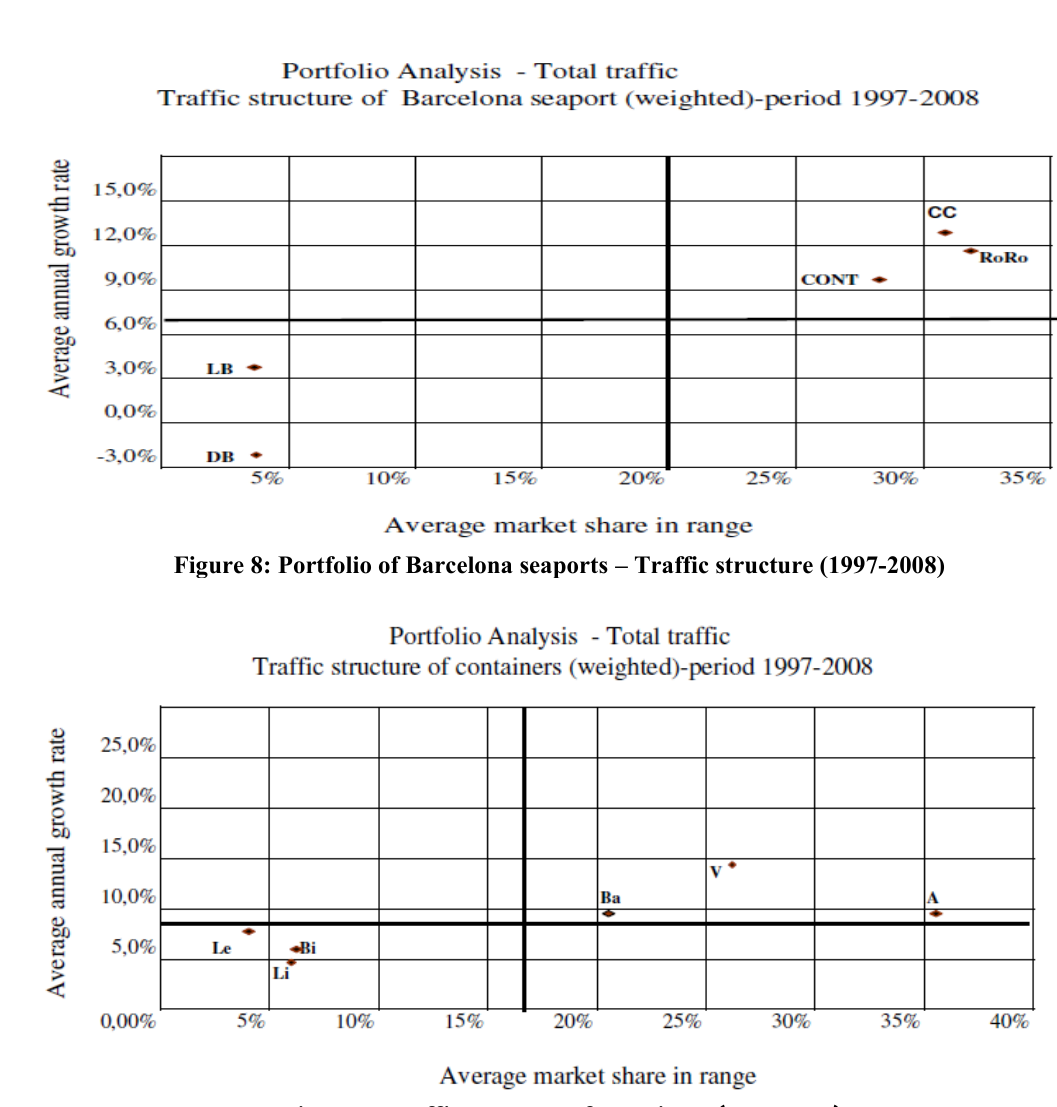
Figure 9: Traffic structure of containers